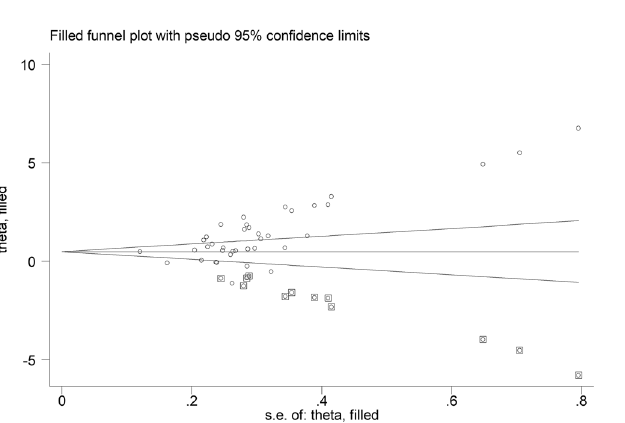
Figure 3. Sensitivity analysis of studies examining asymmetric dimethylarginine (ADMA) concentrations in rheumatic diseases (RDs).